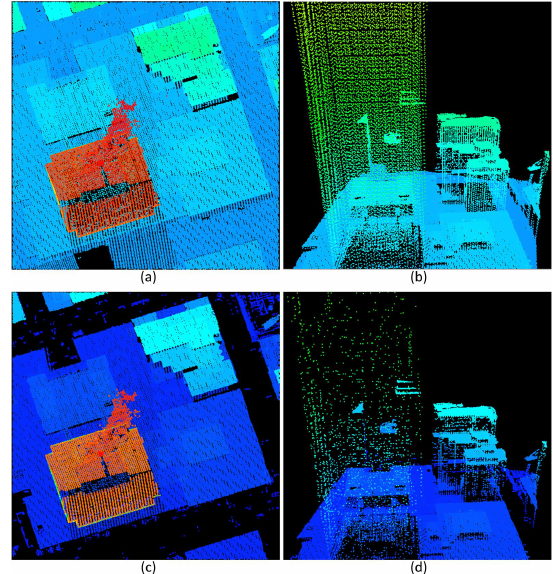
Figure 3: A sample scene from the Toronto data set: (a) LIDAR points, (b) 3D view, (c) non-ground points and (d) non-ground points after removal of wall points. In each figure, points at sim- ilar heights are shown using the same